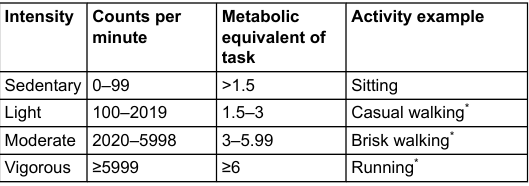
Table 1: Definition of cut offs used for physical activity